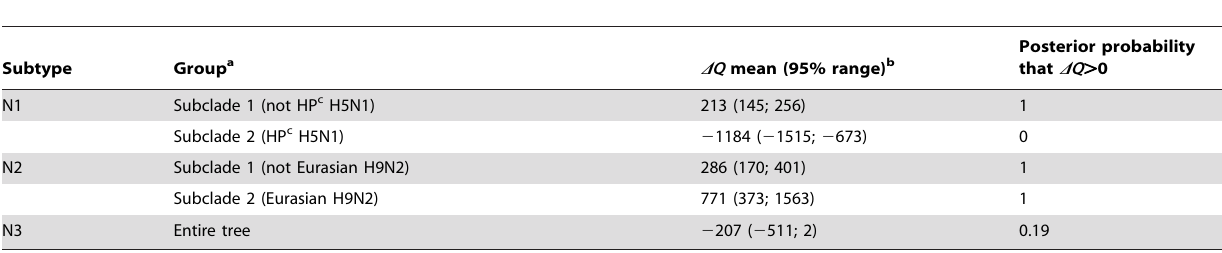
Table 3. Bayesian estimation of joint transitions between Asia and non-Asia and full-length-NA and S D NA.